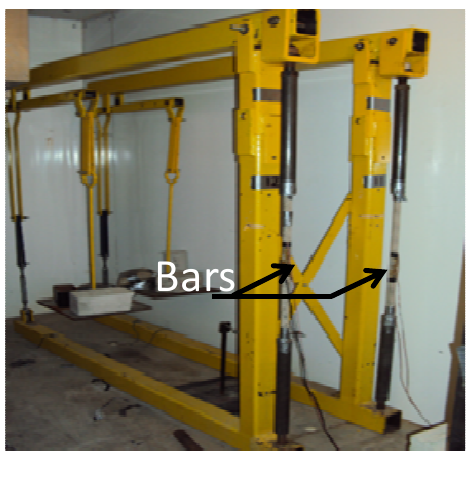
Figure 3. Conditioned tensile test setup of GFRP